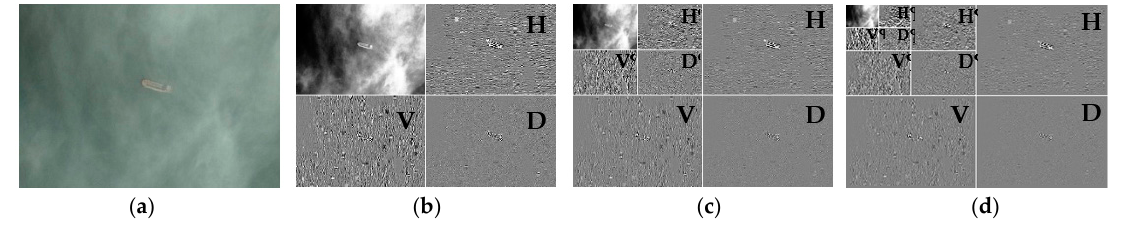
Figure 2. The first three levels of the wavelet decomposition: ( a ) input image; ( b ) j = 1; ( c ) j = 2; and ( d ) j = 3.